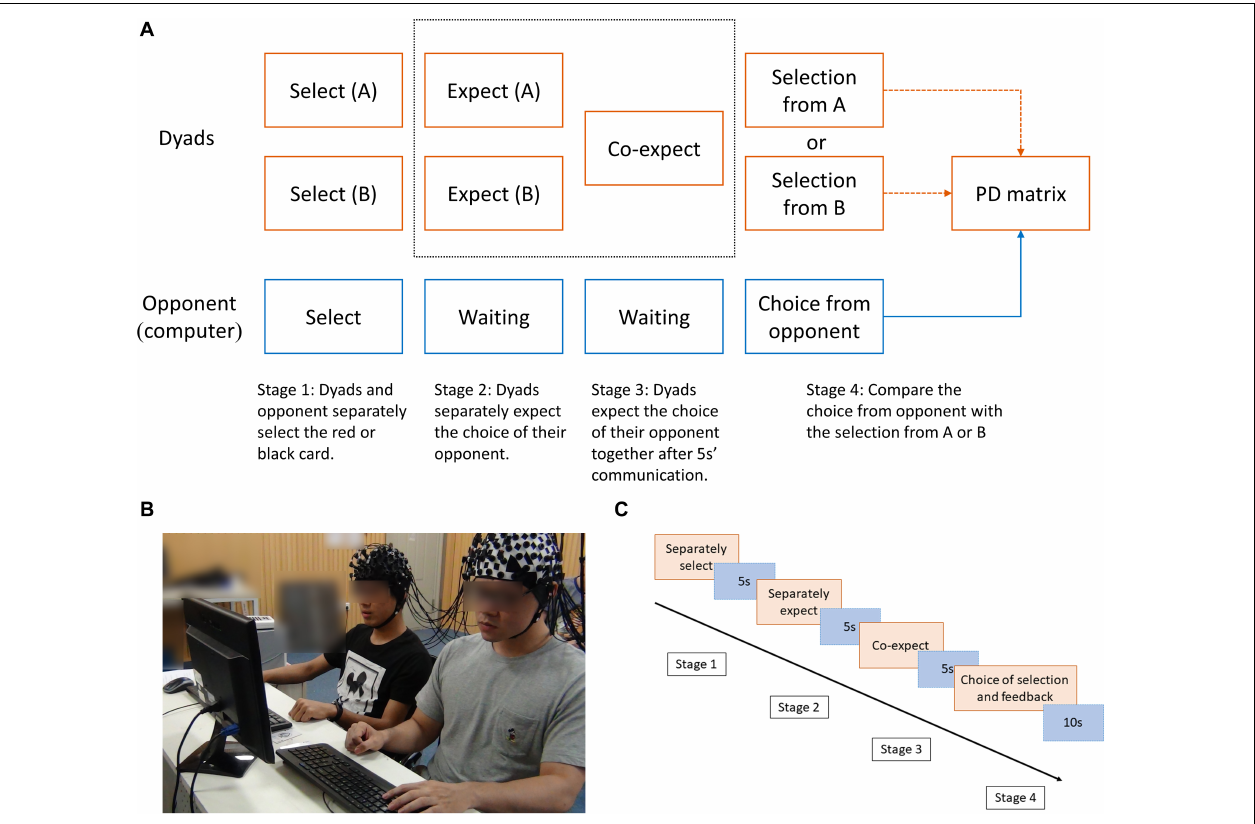
FIGURE 1 | (A) Main experimental procedure. The gray dotted box represents the expectation of cooperation behavior. (B) Experimental setup. The dyads sitting side by side as cooperators. (C) Time process of one trial. The time process was divided into four periods (separate selection, separate expectation, co-expectation, and judging